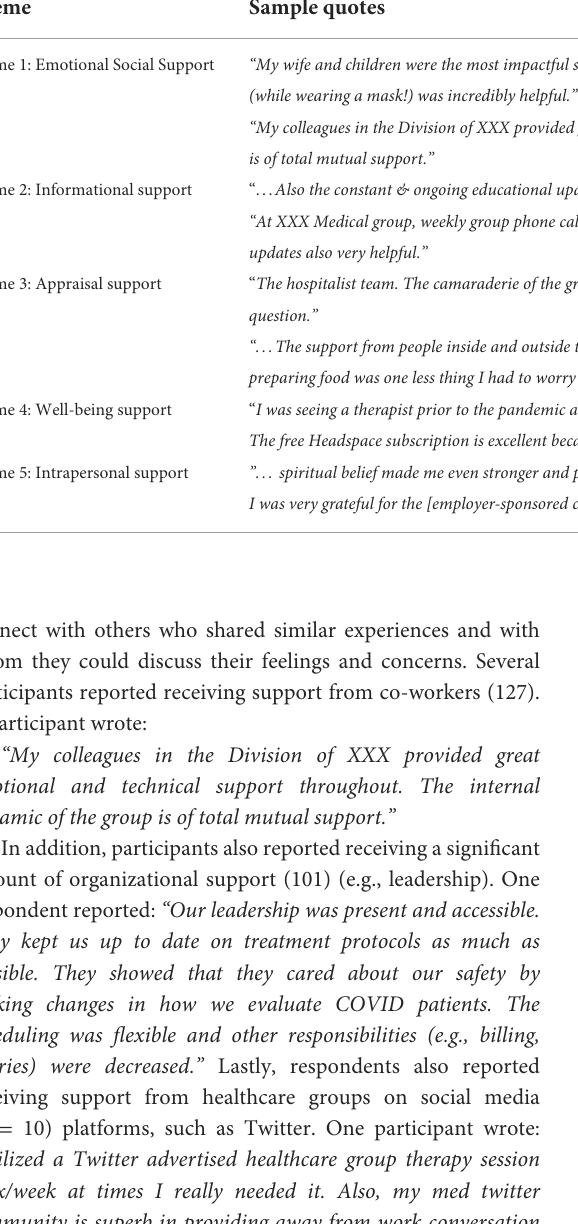
TABLE 3 Themes for